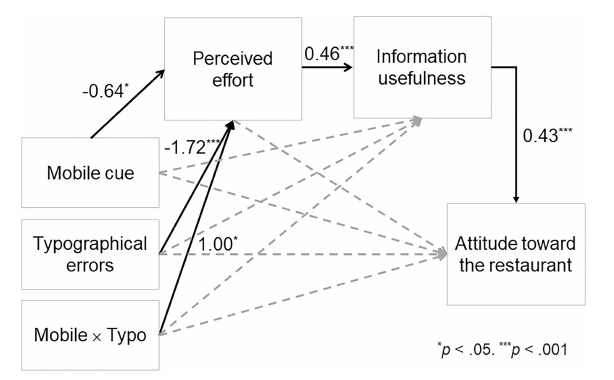
FIGURE 3 | Summary of the direct paths. The solid arrows indicate the significant direct paths, and the numbers next to the arrows are the path